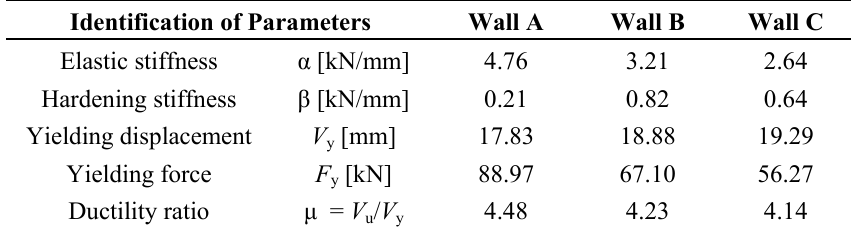
( c ) Table 2. Interpretation of test results according to Method A of EN 12512.